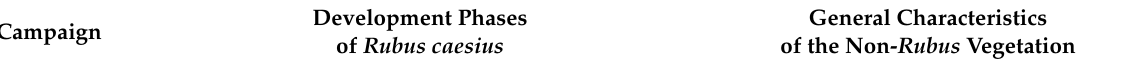
Table 1. The characteristics of Rubus caesius and non- Rubus vegetation in each